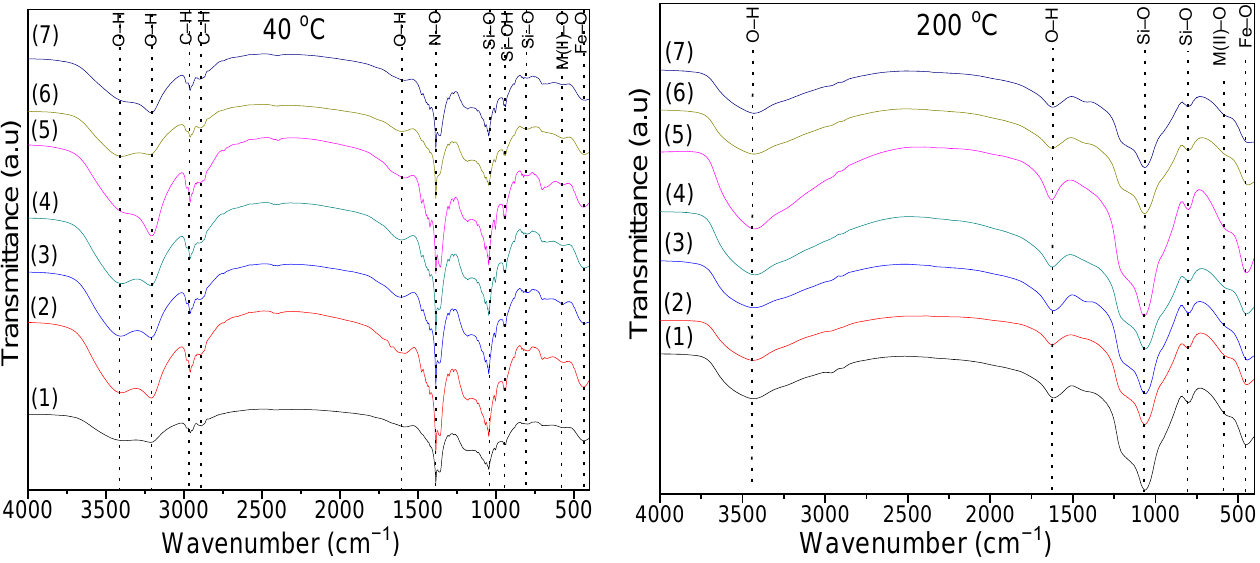
wavenumbers specific to M(II)-O increase. The Jan-Teller effect, determined by the pres- Figure 2. FT-IR spectra of Zn 0.6 Co 0.4 Fe 2 O 4 @SiO 2 Figure 2. FT-IR spectra of Zn 0.6 Co 0.4 Fe 2 O 4 @SiO 2 (1) Ni 0.1 Zn 0.5 Co 0.4 Fe 2 O 4 @SiO 2 (2), Ni 0.2 Zn 0.4 Co 0.4 Fe 2 O 4 @SiO 2 (3), Ni 0.3 Zn 0.3 Co 0.4 Fe 2 O 4 @SiO 2 (4) Ni 0.4 Zn 0.2 Co 0.4 Fe 2 O 4 @SiO 2 (5) Ni 0.5 Zn 0.1 Co 0.4 Fe 2 O 4 (M = Co, Ni, Zn). The Co 3+ ion may migrate to tetrahedral (A) sites, while the Fe 2+ ions Ni 0.5 Zn 0.1 Co 0.4 Fe 2 O 4 @SiO 2 (6) and Ni 0.6 Co 0.4 Fe 2 O 4 @SiO 2 (7) samples at 40 and 200 °C. @SiO 2 (6) and Ni 0.6 Co 0.4 Fe 2 O 4 @SiO 2 (7) samples at 40 and 200 ◦ C.